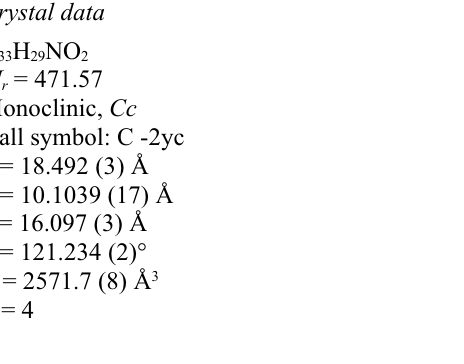
The 1-D chain, viewed along the a axis. Dashed lines indicate the C—H··· π interaction between the neighbouring molecules [symmetry code: (i) x , -1 + y , z ]. H atoms not involved in the interaction have been omitted for clarify. (Pyridine-2,6-diyldimethylene)bis(diphenylmethanol) Crystal